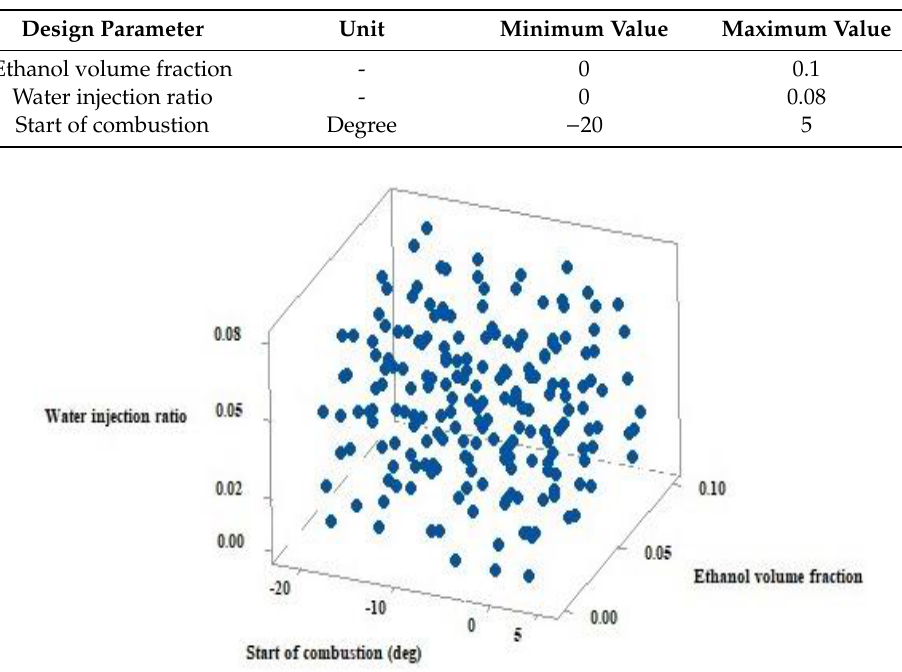
Table 3. Maximum and minimum values of each design parameter.